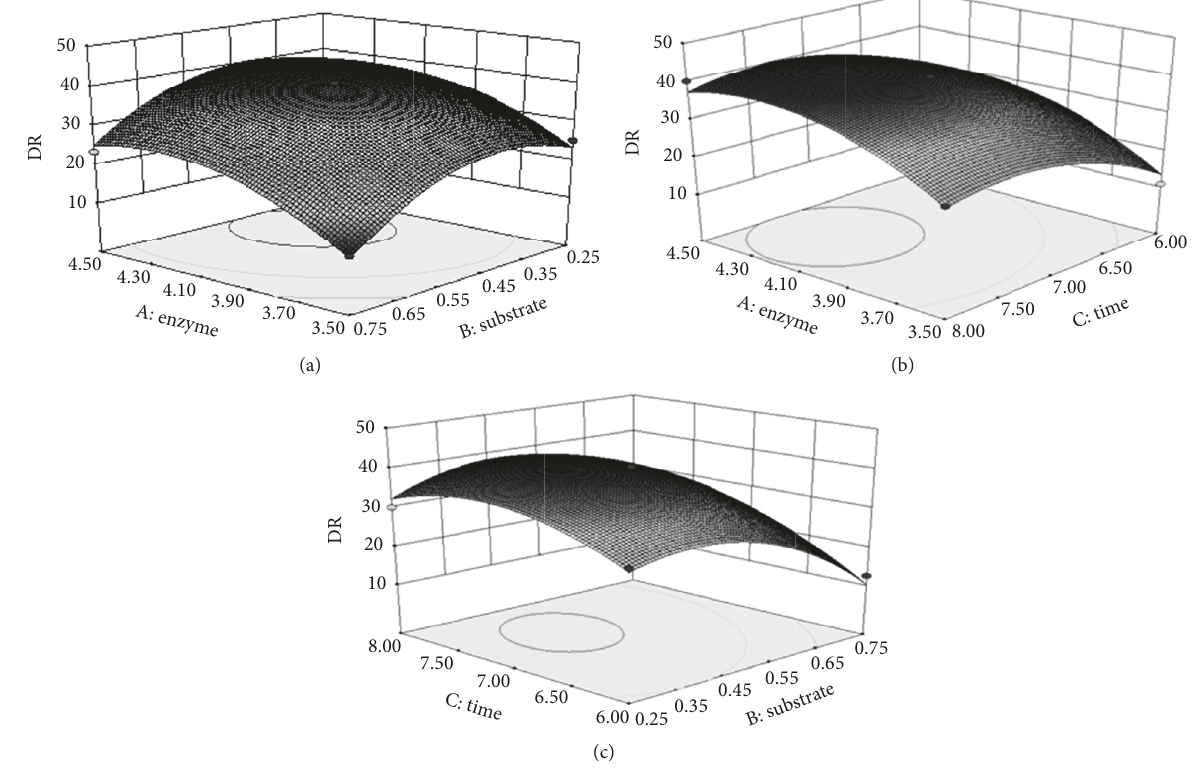
Figure 2: Response surface plot for acid degradation of polysaccharides on the effect of (a) varying enzyme concentration (mL) and substrate concentration (mL), (b) varying time (hour) and enzyme concentration (mL), and (c) varying time (hour) and substrate concentration